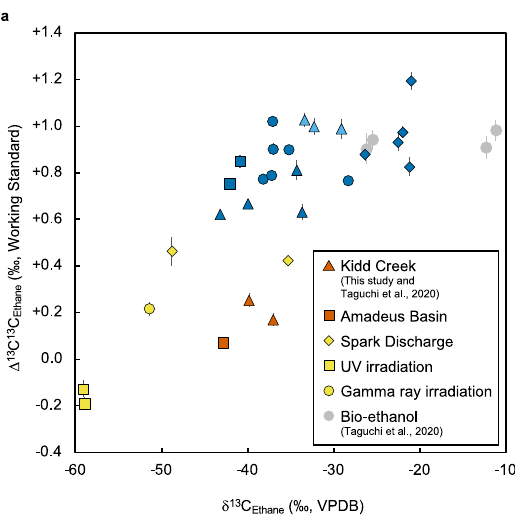
Fig. 1 | Results of Δ 13 C 13 C and compound-speci fi c isotopic analysis (CSIA) of hydrocarbons ( δ 13 C). a Relationship between Δ 13 C 13 C Ethane and δ 13 C Ethane value normalised against Vienna Pee Dee Belemnite (VPDB). Symbols are the same as shown in the legend of panel b . Grey circles denote bio-ethanol from three plants: theC3-type,theC4-type,andtheCrassulaceanAcidMetabolism(CAM) 19 .Lightblue triangles represent ethene (C 2 H 4 ) produced by propane pyrolysis (see Methods).